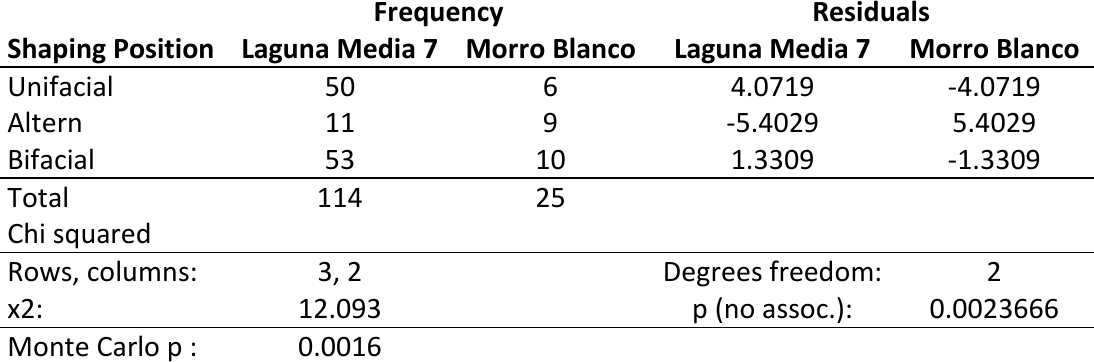
Table 7. Frequencies and normalized residuals for the shaping position in the tools from Laguna Media 7 and Morro Blanco - x 2 and Monte Carlo